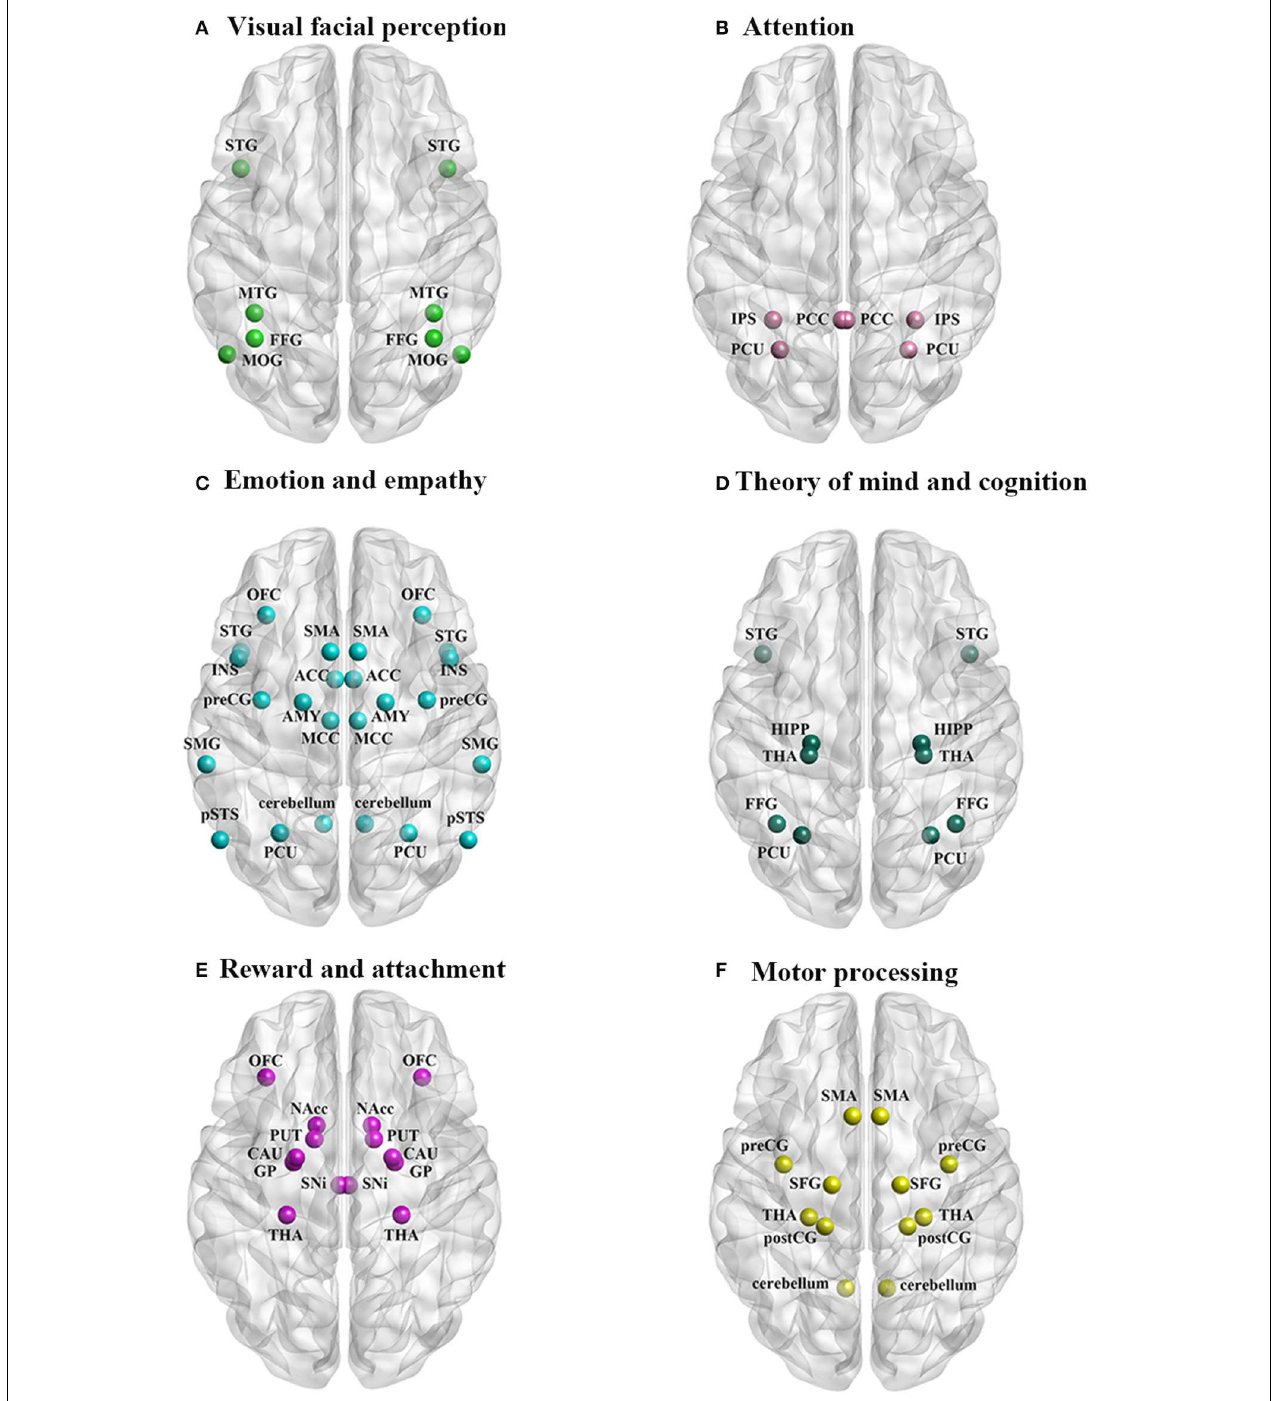
FIGURE 1 | The neural circuitry activated by perception of infant faces in parents and non-parents of both sexes associated with: (A) visual facial perception, (B) attention, (C) emotion and empathy, (D) theory of mind and cognition, (E) reward and attachment, and (F) motor processing.